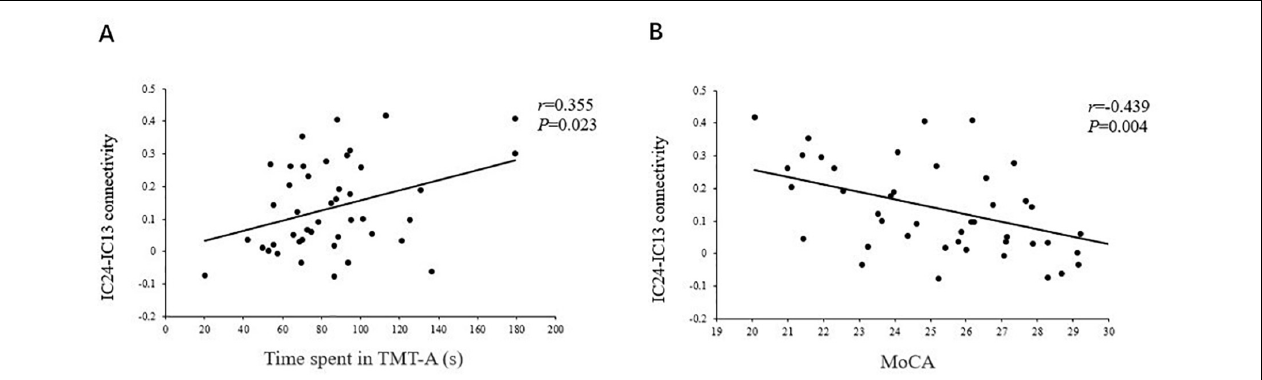
FIGURE 6 | The correlations of the strength of connectivity between the IC24 and IC13 in the DAN and the DMN with the TMT scores ( r = 0.355, P = 0.023) (A) , and the MoCA scores ( r = –0.439, P = 0.004) (B) .